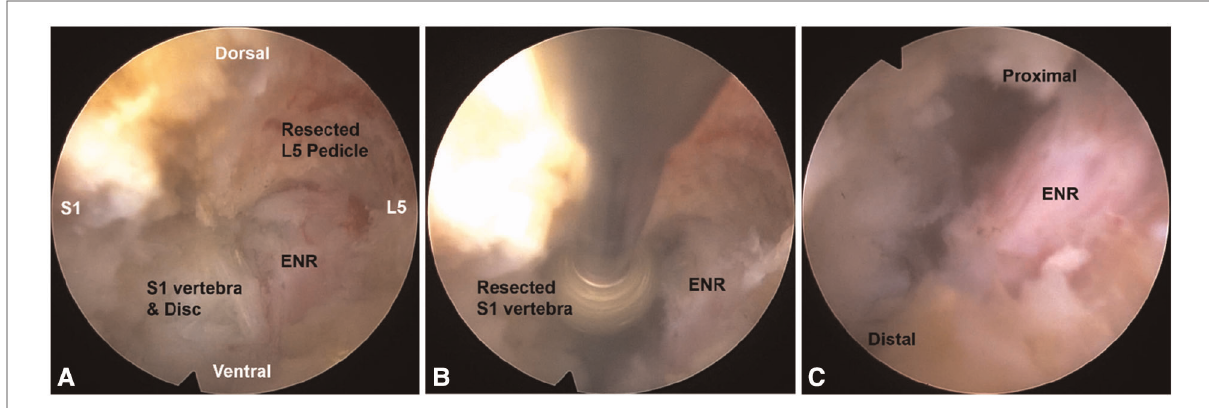
FIGURE 2 Intraoperative endoscopic views. Foraminal unroo fi ng with the removal of the upper pedicle (A) and lower vertebral endplate (B) compressing the exiting nerve root (ENR). After the full-scale decompression, the ENR was freely released from the proximal axillary zone to the lateral exit zone (C) .